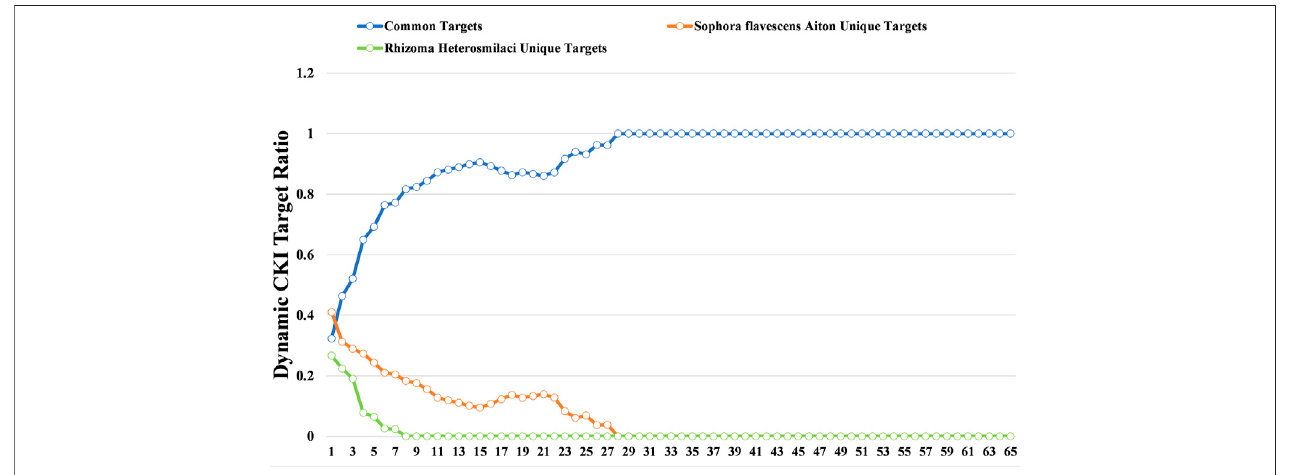
FIGURE 3 | Dynamic ratio changes between common targets and unique targets of Rhizoma Heterosmilacis and Radix Sophorae Flavescentis